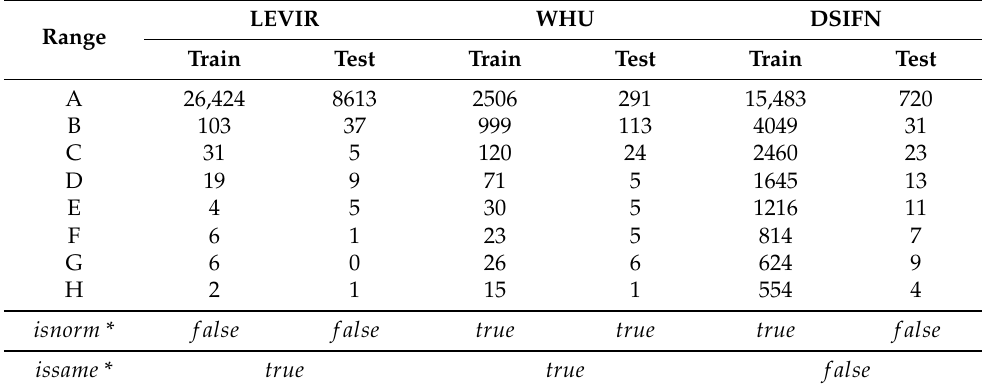
Table 9. The statistics of the number of regions with different size change in the three datasets.